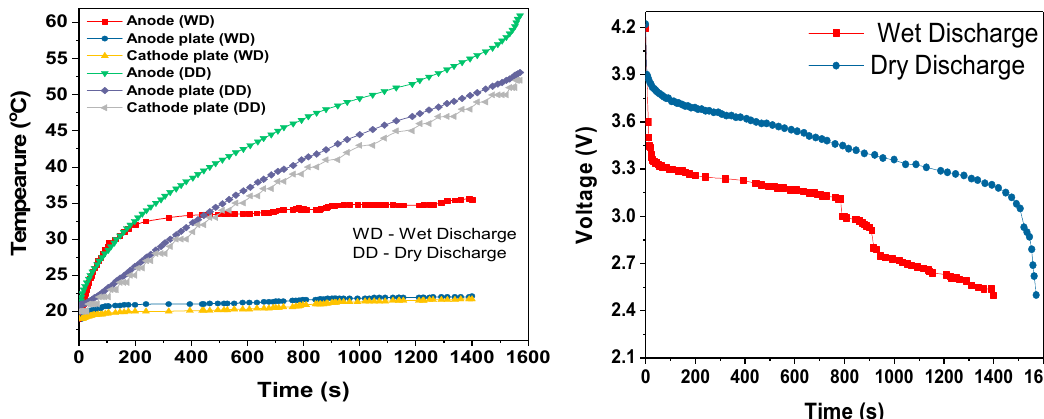
Figure 14. Measured voltage and temperature versus time for the six-cell battery module for the 2C wet and dry discharge rates, measured at various points in the